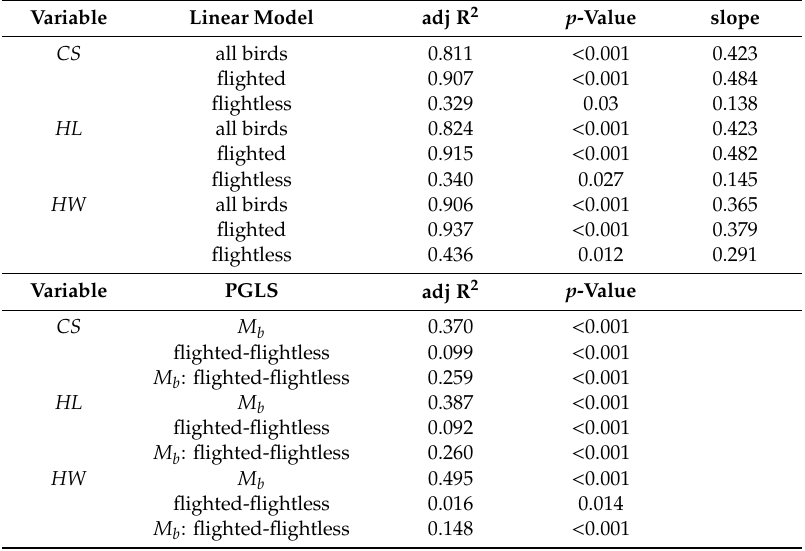
Table 1. Summary of bivariate regressions of body mass ( M b ) on humeral size